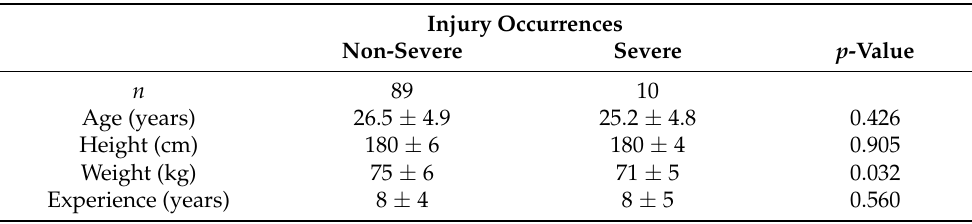
Table 2. Subjects’ characteristics divided between non-severe and severe injury occurrences (pre- sented as the mean ±